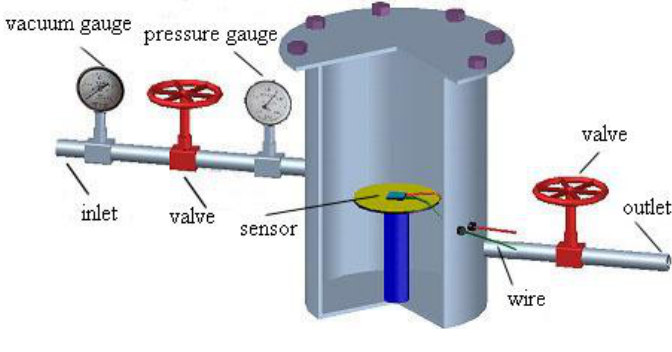
Figure 4. Structure of the gas chamber used for testing